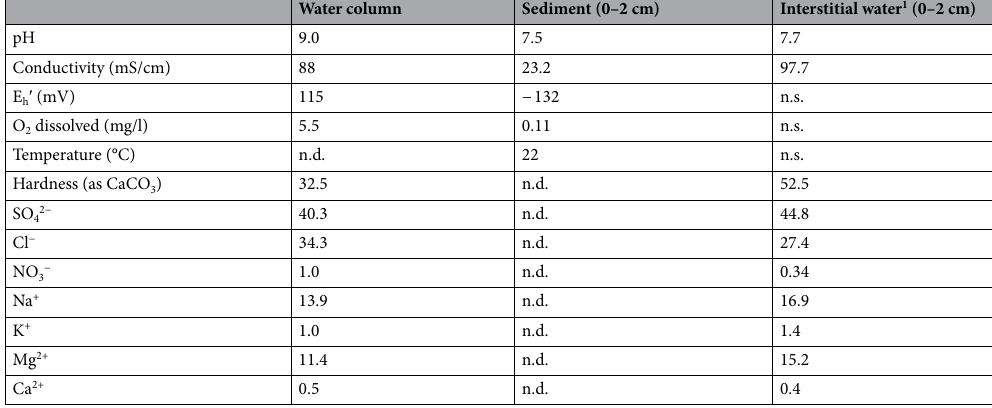
Table 1. Physico-chemical parameters, anions and cations of the Tirez lagoon (April 2002). Concentrations are expressed as g L −1 . 1 Measurements were taken with interstitial water obtained by centrifugation of the sediments. n.d. not determined, n.s. no sense. The following physico-chemical parameters were measured in situ before the desiccation of the lagoon: temperature and conductivity (Orion 120), pH and redox potential (Orion 420), and dissolved oxygen (Symplair Sylaud Ins.). Sulfate and carbonate were also determined in situ with Hanna Instruments kits (Hanna Sulfate LR-HR H1-38001A for sulfate and Hardness HR H1-3812 for carbonate). Other anions and cations (Cl − , Na + , K + , Mg 2+ , Ca 2+ ) were determined in the laboratory by elemental TXRF analysis and NO 3 − by ionic